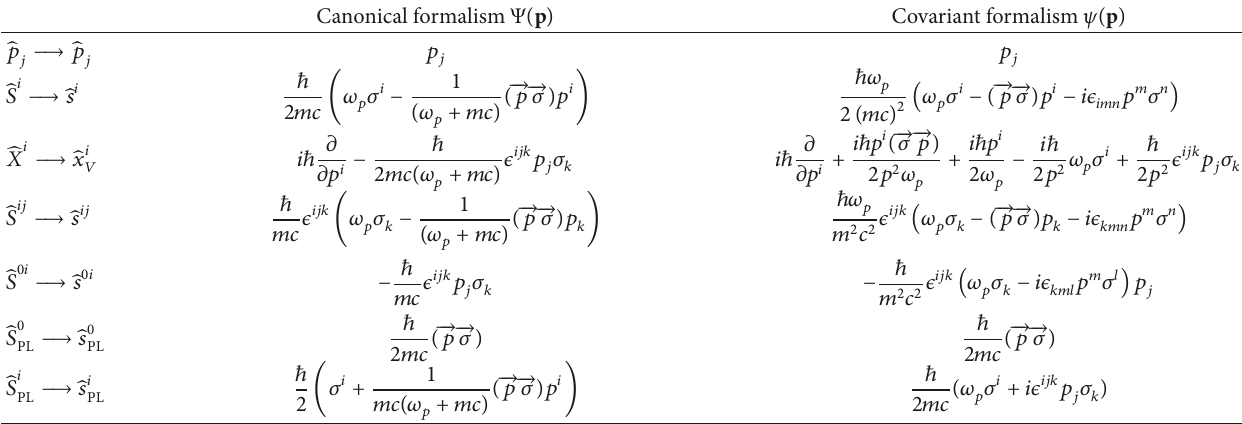
Table 5: Operators of canonical and manifestly covariant formulations in momentum